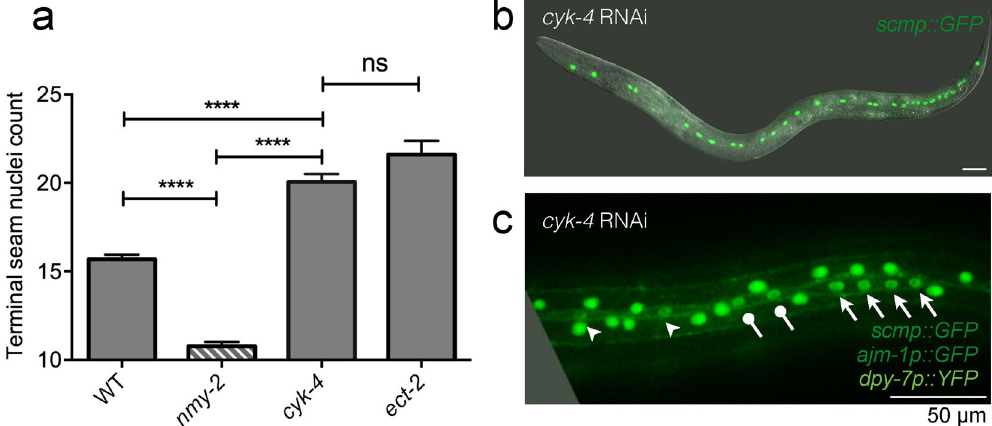
Figure 5. Disrupting cytokinesis alone increases terminal seam nuclei count. ( a ) Post-embryonic cyk-4 and ect-2 RNAi produced extra terminal seam nuclei. Synchronised L1 larvae were fed the respective RNAi bacteria at 25 °C and terminal seam nuclei were counted in young adult hermaphrodites using the wIs51 seam cell marker. n > 50 for each sample. Error bars represent the SEM. Unpaired, two-tailed t -test was used to determine significance ( **** p < 0.0001; ns: p = 0.09). Two independent replicates of the experiment were performed. ( b , c ) Representative images of cyk-4 RNAi adults showing ( b ) seam hyperplasia (strain JR667) and ( c ) unevenly spaced terminal seam nuclei (strain AW1147). Arrows and lollipop arrows point to nuclei that cluster together, and arrowheads point to nuclei that are more sparsely distributed. The phenotypes were virtually identical between cyk-4 and ect-2 RNAi, so the ect-2 data are omitted for